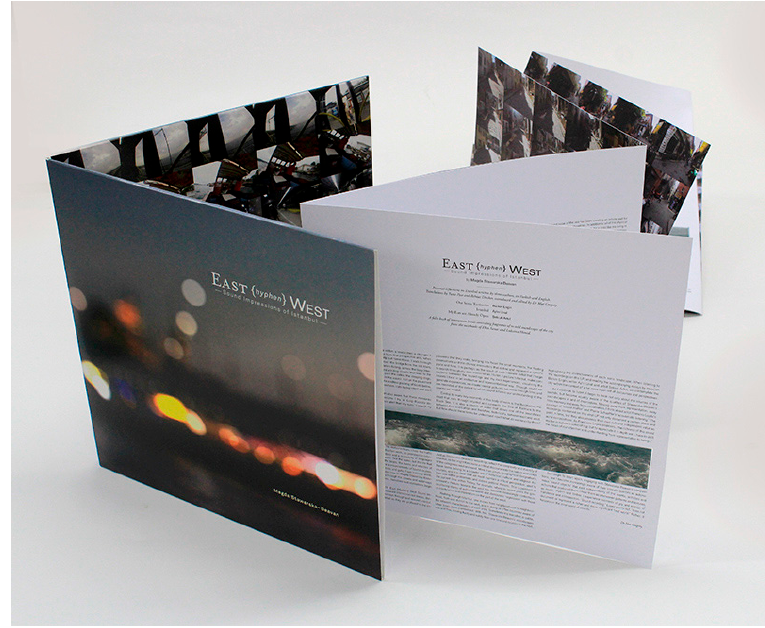
Figure 8. East {hyphen} West, Sound Impressions of Istanbul (2015) by Magda Stawarska-Beavan. Photo by Gavin Renshaw. Used with permission.